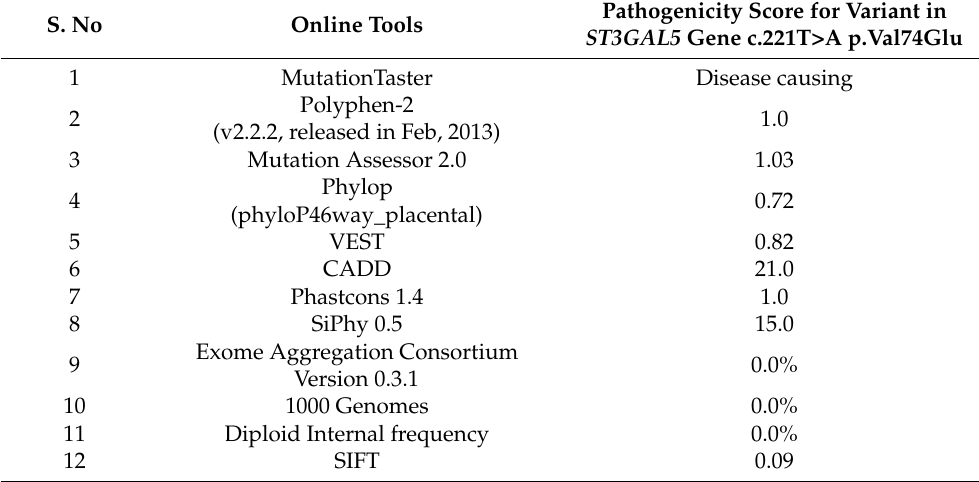
Table 2. The details of in silico analysis conducted for this study. CADD-Combined Annotation Dependent Depletion; VEST (Variant Effect Scoring Tool), SIFT (Sorting Intolerant Form